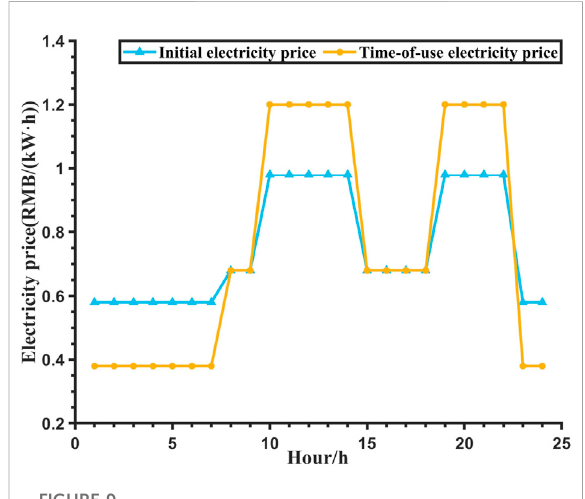
FIGURE 9 Comparison of electricity prices before and after DR.